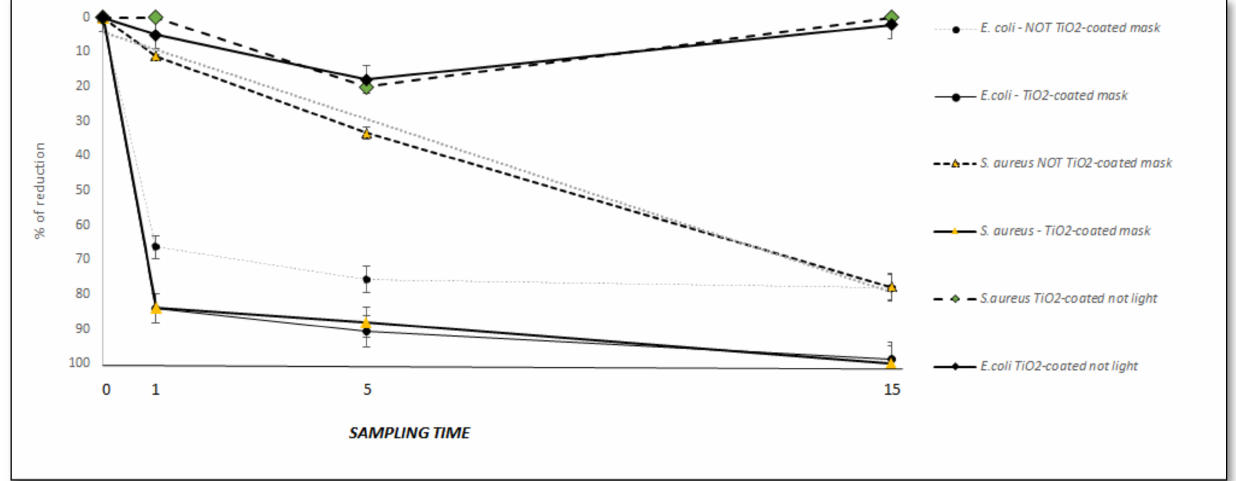
Figure 7. The reduction trend of E. coli and S. aureus in the FFP2 mask coated by TiO 2 . The percentage of the reduction of E. coli and S. aureus as a function of the times of exposure at blue light are reported. The level of E. coli and S. aureus decreases with increasing times of exposure at blue light, but a significant enhancement of the antimicrobial activity was observed when exposing coated-TiO 2 masks. Sampling times were 0, 5, and 15